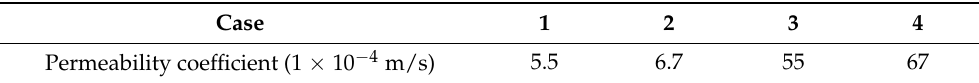
Table 5. Permeability coefficients for the four cases.